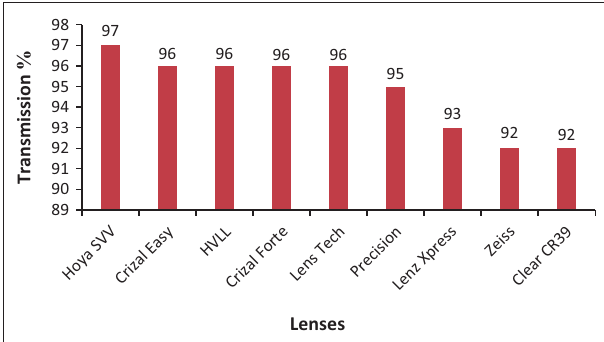
FIGURE 6: The amount of visible light transmitted, as a percentage (between 400 nm and 760 nm), through each lens. The percentage is shown at the top of each bar.